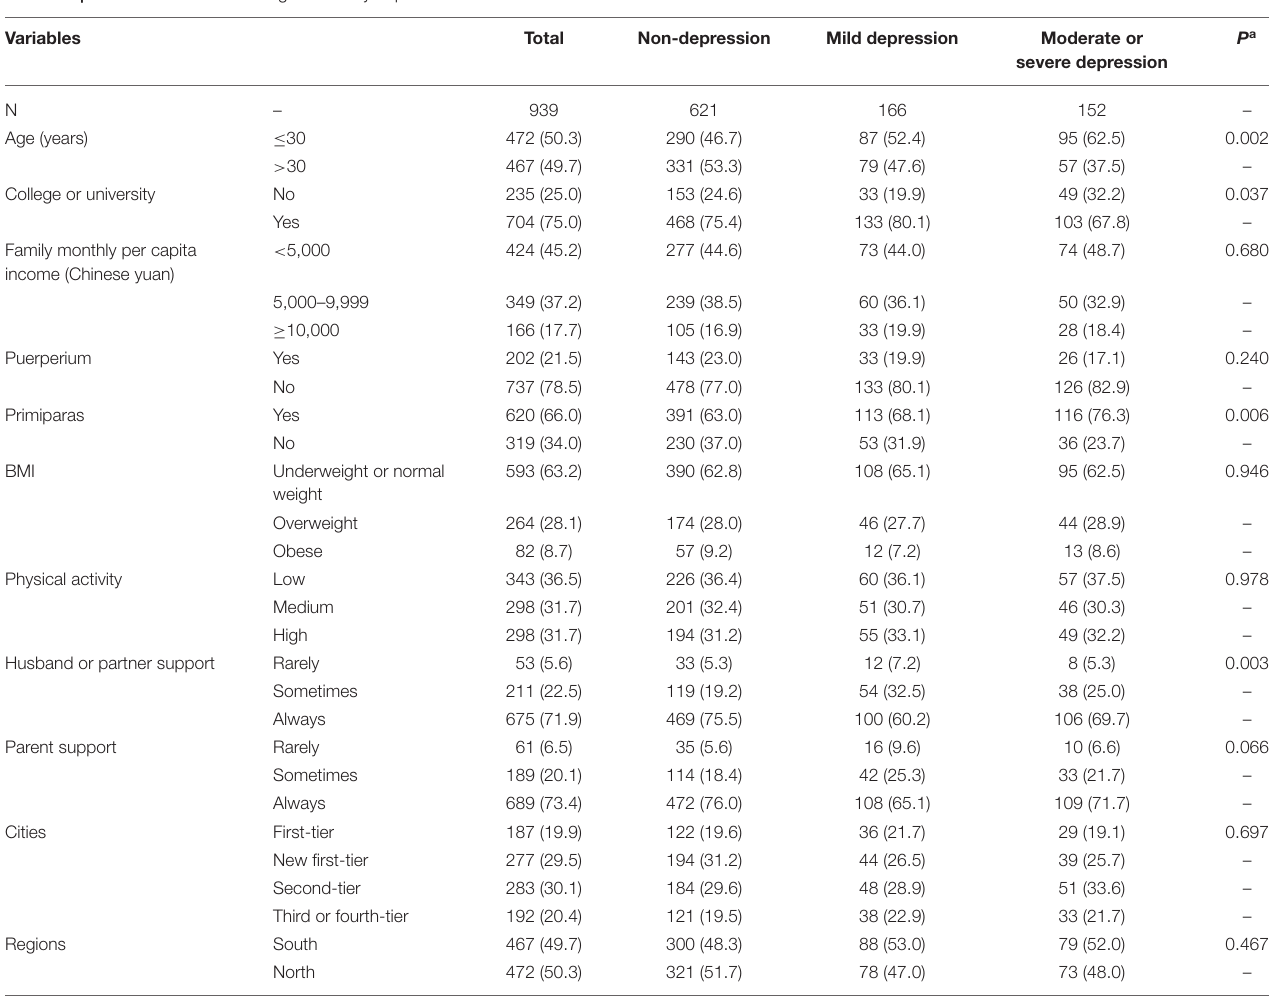
TABLE 1 | Characteristics of lactating women by depression